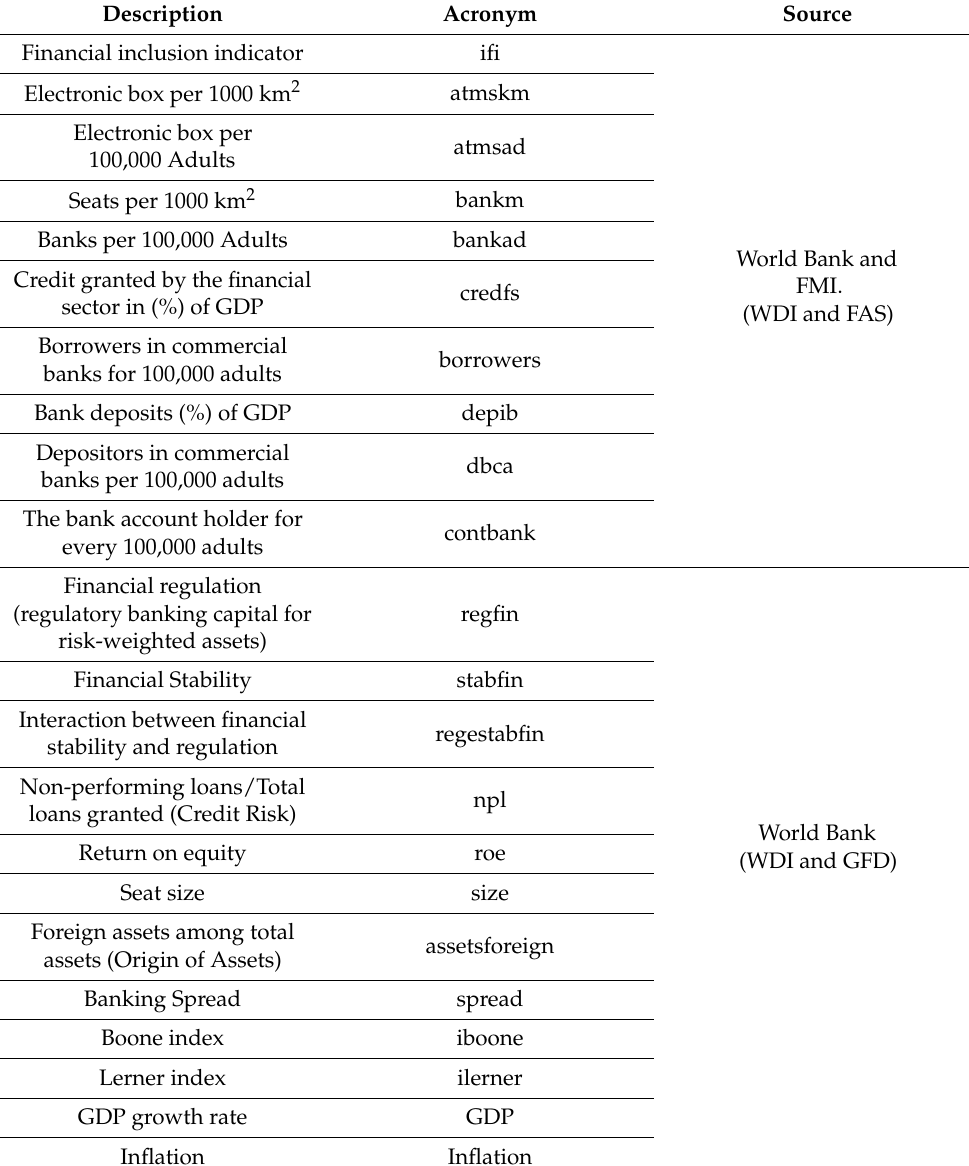
Table 1. Definition of variables and